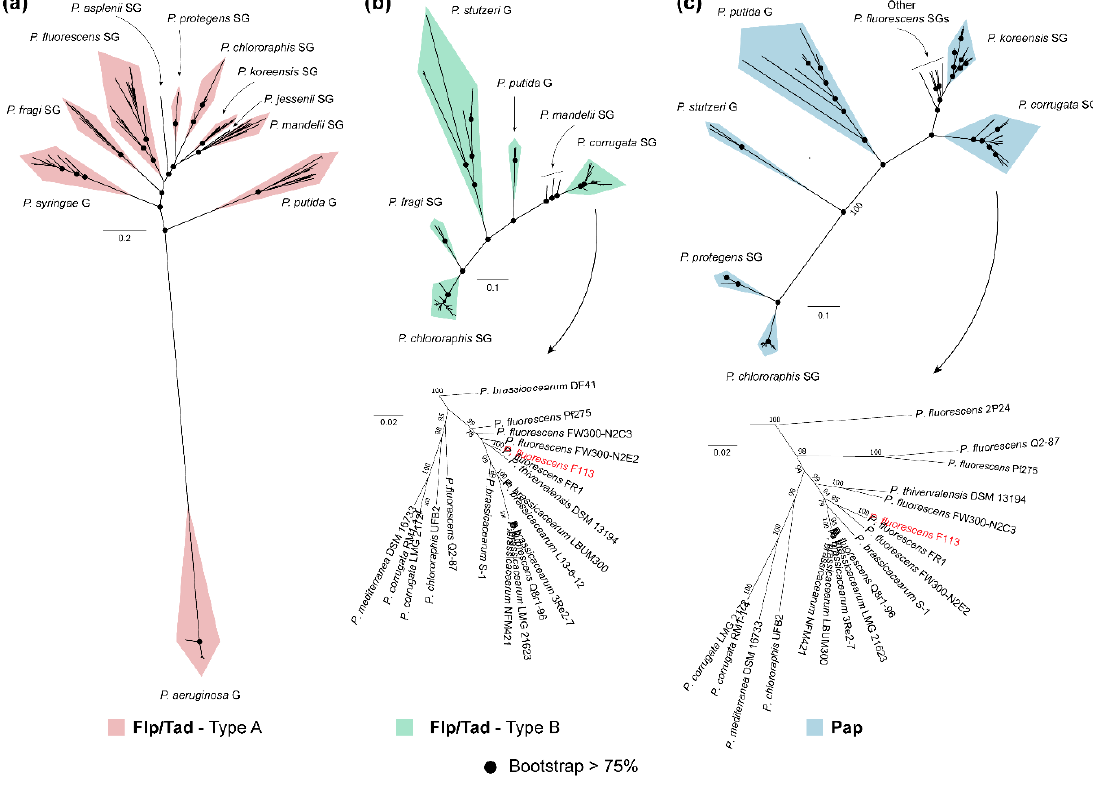
Figure 5. Phylogenetic analysis of Flp / Tad and Pap components in the genus Pseudomonas . Unrooted ML trees of Flp / Tad type A ( a ), Flp / Tad type B ( b ) and Pap ( c ) components within pseudomonads built using the concatenated alignment of TadZG, PprB, FppA, TadF, and PprA ( a ); TadB, PSF113-4189, TadEGZ, and CpaE-like ( b ); and PapDEFHIJLMO ( c ), respectively. Black dots in nodes indicate bootstrap values equal to or greater than 75%. Taxa belonging to Pseudomonas corrugata subgroup from the P. fluorescens group, which includes P. fluorescens F113 (red typing), is shown in greater detail at the bottom of Flp / Tad type B ( b ) and Pap ( c ) matrix components. The complete list of taxa used in this analysis can be found in Supplementary Table S6.